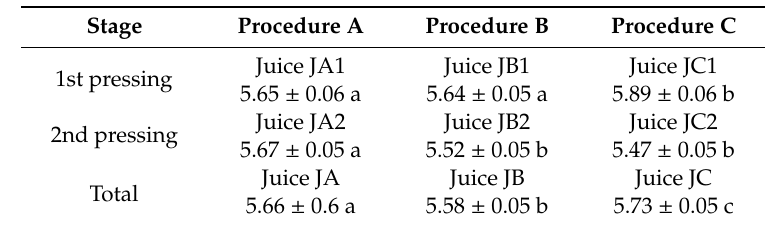
Table 3. pH of juice from celeriac root pulp according to the selected procedure and pressing stage. Abbreviations as on Figure 3.